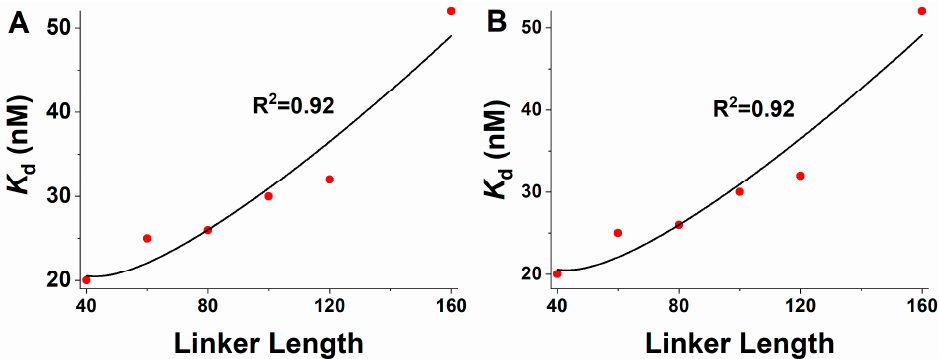
Figure 2. Fitted correlation between the VRN1 linker length and binding affinity to DNA. The linker length is measured by the number of residues. Scatterings are experimental data, as listed in Table 1. Solid lines are the fitting results by ( A ) the WLC model and ( B ) the RMC model with Equations (2) and (4). The resulting fitted parameters are r e = 31.6 Å and p 0 = 0.007 in ( A ) and r e = 24.9 Å and p 0 = 0.004 in ( B ).